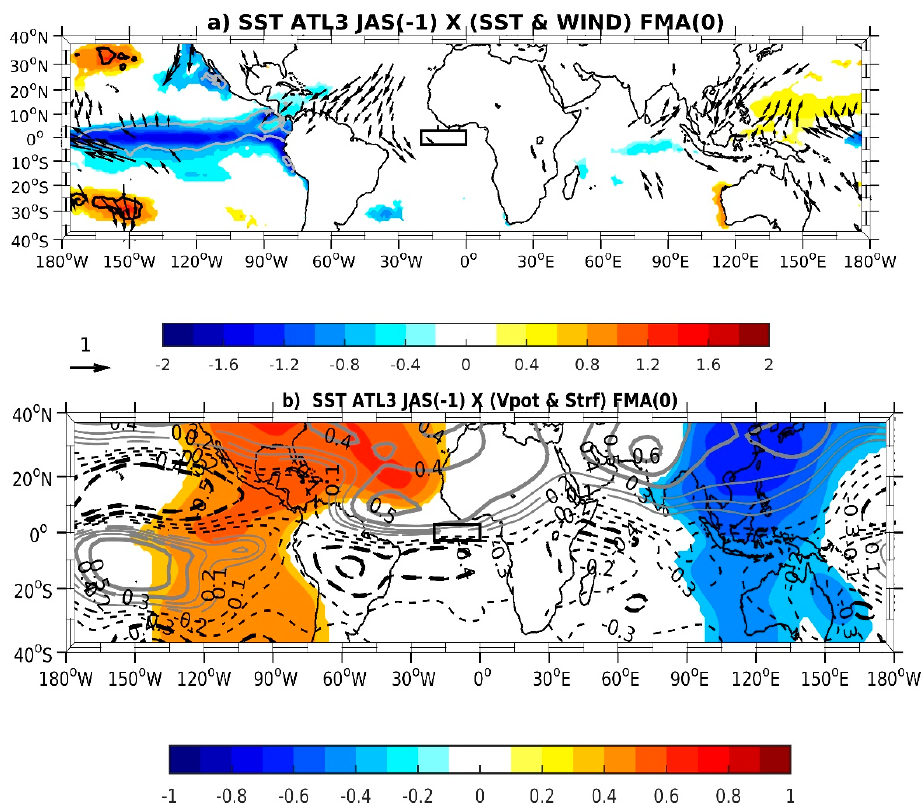
Figure 7. Distribution of the lagged linear correlation / regression of the gridded ( a ) SST ( ◦ C / ◦ C, shaded) and surface wind (u and v, m s − 1 / ◦ C, vectors) anomalies ( b ) velocity potential at 200 hPa (shaded) and stream function at 200 hPa (contours) anomalies over the global ocean in FMA(0) with SSTA inside ATL3 (oceanic black box) in JAS( − 1) for all the years (36 years) during 1980–2015. The correlations that are significant at a 95% confidence level, according to the t -test, are plotted for both SST and wind. Contours indicate regions of correlation higher than +0.5 for SST ( a ). The continental black box indicates the Northern NEB region.